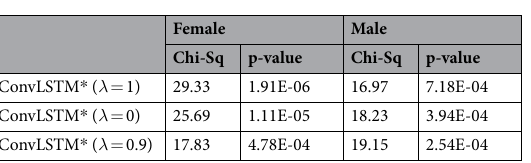
Table 6. Results of Log-rank tests applied on the normalized biological age acceleration η = ( CA − BA )/ CA using separate models for female and male